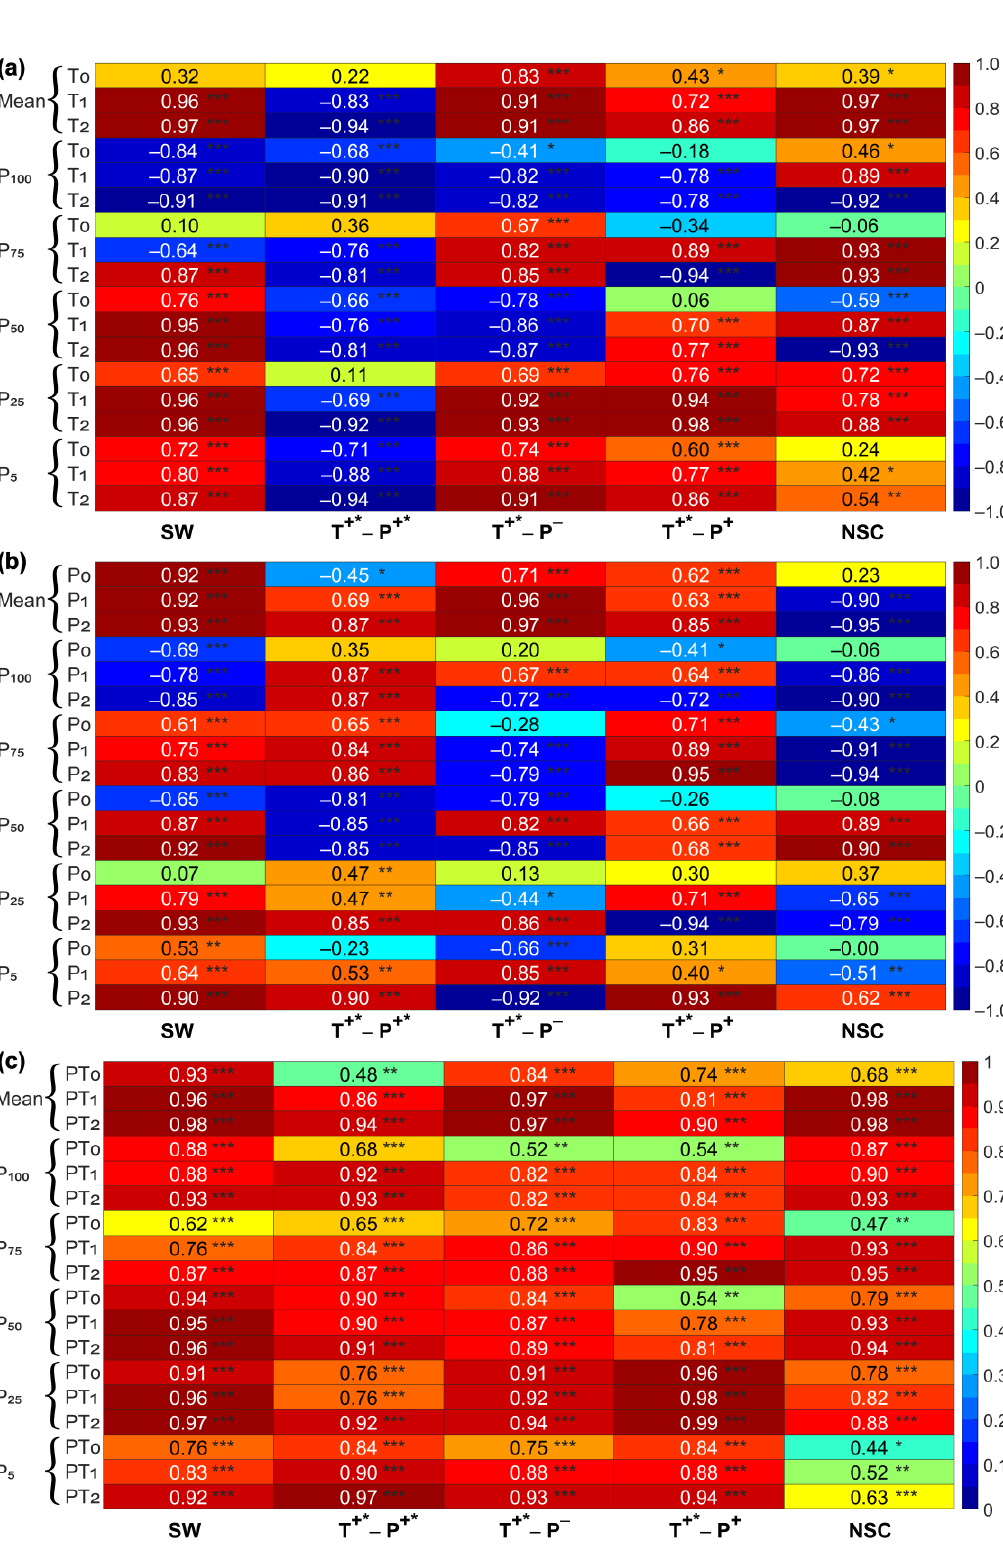
Figure 4. The strength of the time lag effect of ( a ) the temperature factor, ( b ) the precipitation factor, and ( c ) multiple combinations of climate factors. T, P, and PT represent temperature, precipitation, and precipitation and temperature, respectively. The numbers 0, 1, and 2 of the lower indices represent the same period, respectively, considering the annual and interannual time lag. “*”, “**”, and “***” demonstrate the importance of p < 0.1, p < 0.05, and p < 0.01, respectively.